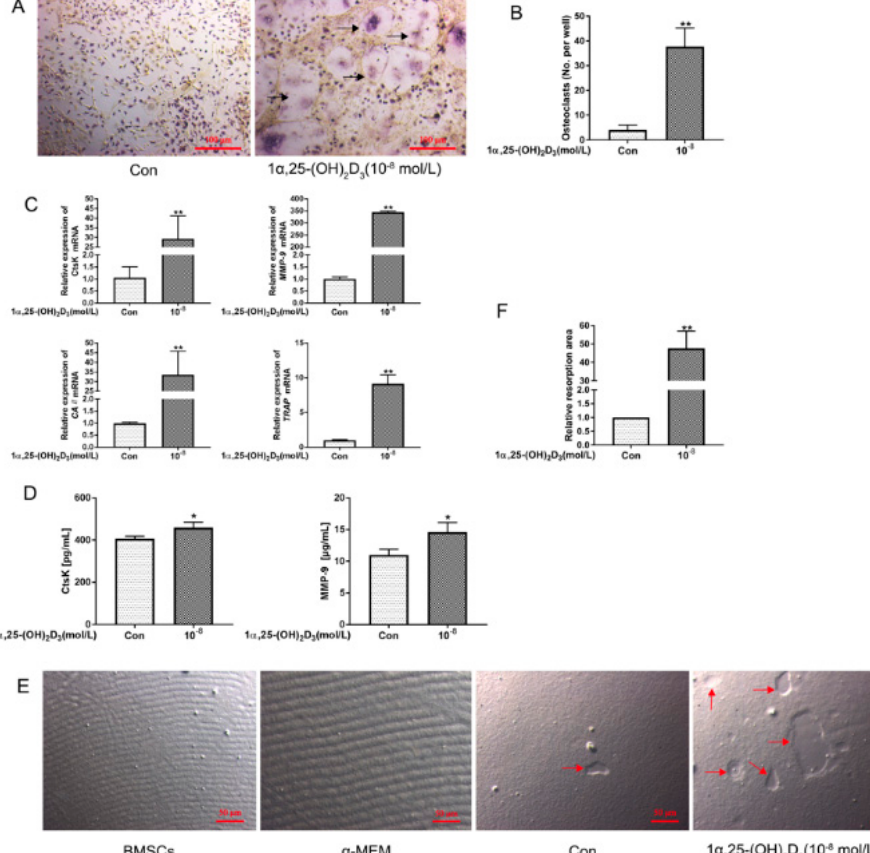
Figure 1. Culture with 10 − 8 mol/L 1 α ,25(OH) 2 D 3 promotes osteoclastogenesis and bone resorption in the chicken BMSC–BMM co-culture system. ( A , B ) BMSCs and BMMs were co-cultured on 6-well plates with or without (Con) addition of 10 − 8 mol/L 1 α ,25(OH) 2 D 3 . Cells were treated for 5 d, and 10 fields were randomly selected. The number of TRAP-positive multinucleated OCs (black arrows) was counted. Bar = 100 µ m. ( C , D ) BMSCs and BMMs were co-cultured on 6-well plates with or without (Con) addition of 10 − 8 mol/L 1 α ,25(OH) 2 D 3 . Cells were treated for 5 d, and qRT-